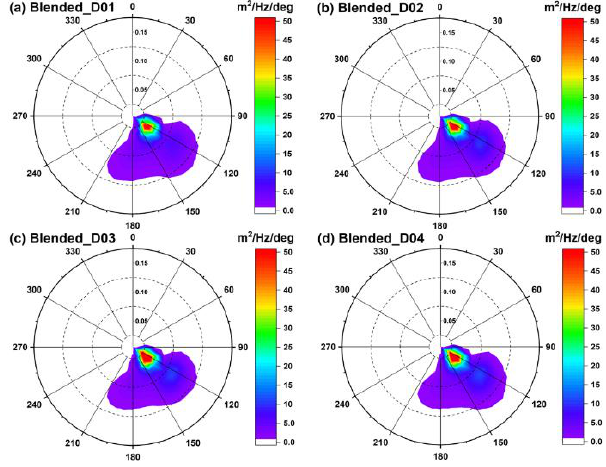
Figure 18. Comparison of the directional wave spectra at the Taitung wave buoy at 00:00 on 14 September 2016, using the four computational domains ( a – d ) and blended wind fields.